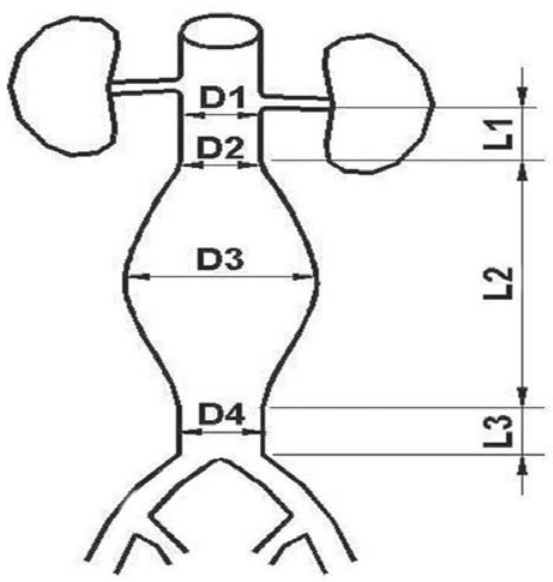
Fig. 1 - Diâmetros(D) e extensões(L) proximais